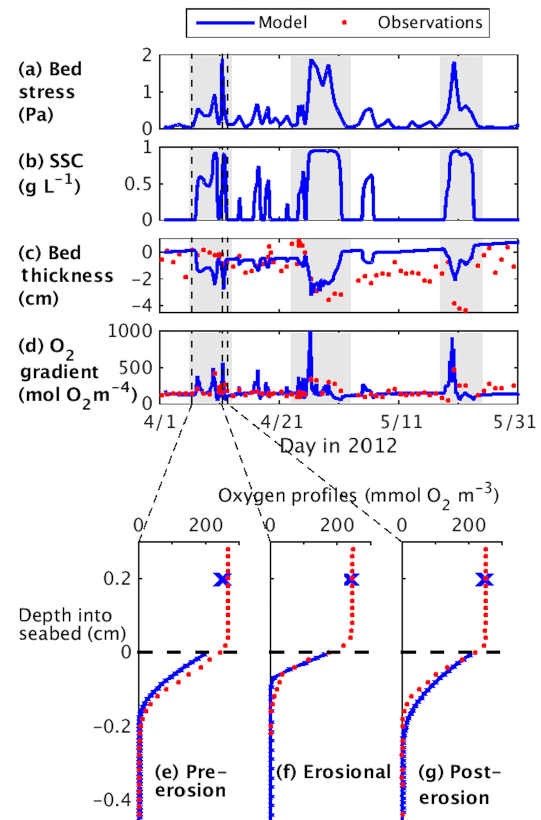
Figure 3. Time series of modeled (blue lines and x ’s) and observed (red dots; Toussaint et al., 2014) bed stress, near-bed suspended sediment concentrations (SSC), seabed height, and vertical oxygen gradient averaged over the oxic layer of the seabed (top 4 panels), and three examples of oxygen profiles before (6 April 2012), during (9 April 2012), and after (12 April 2012) an erosional event in early April (bottom panels). The dashed black lines in the bottom panels indicate the seabed–water interface. Shading in the top panels indi- cates resuspension events, i.e., cycles of erosion and redeposition, including 6–13 April, 23 April–3 May, and 18–25 May